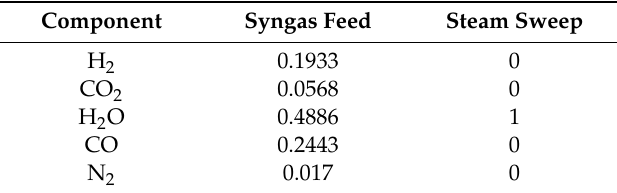
Table 2. Molar composition of inlet streams, given in mole fraction.